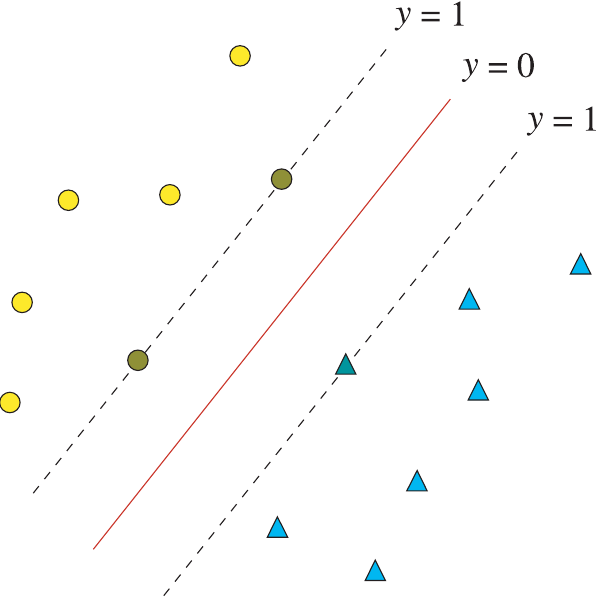
Figure 9. Maximum margin hyperplane used in support vector machines. Example showing the hyperplane with maximal margin of separation between samples from two different haplogroups. The shaded points lying on the margin define the support vectors.